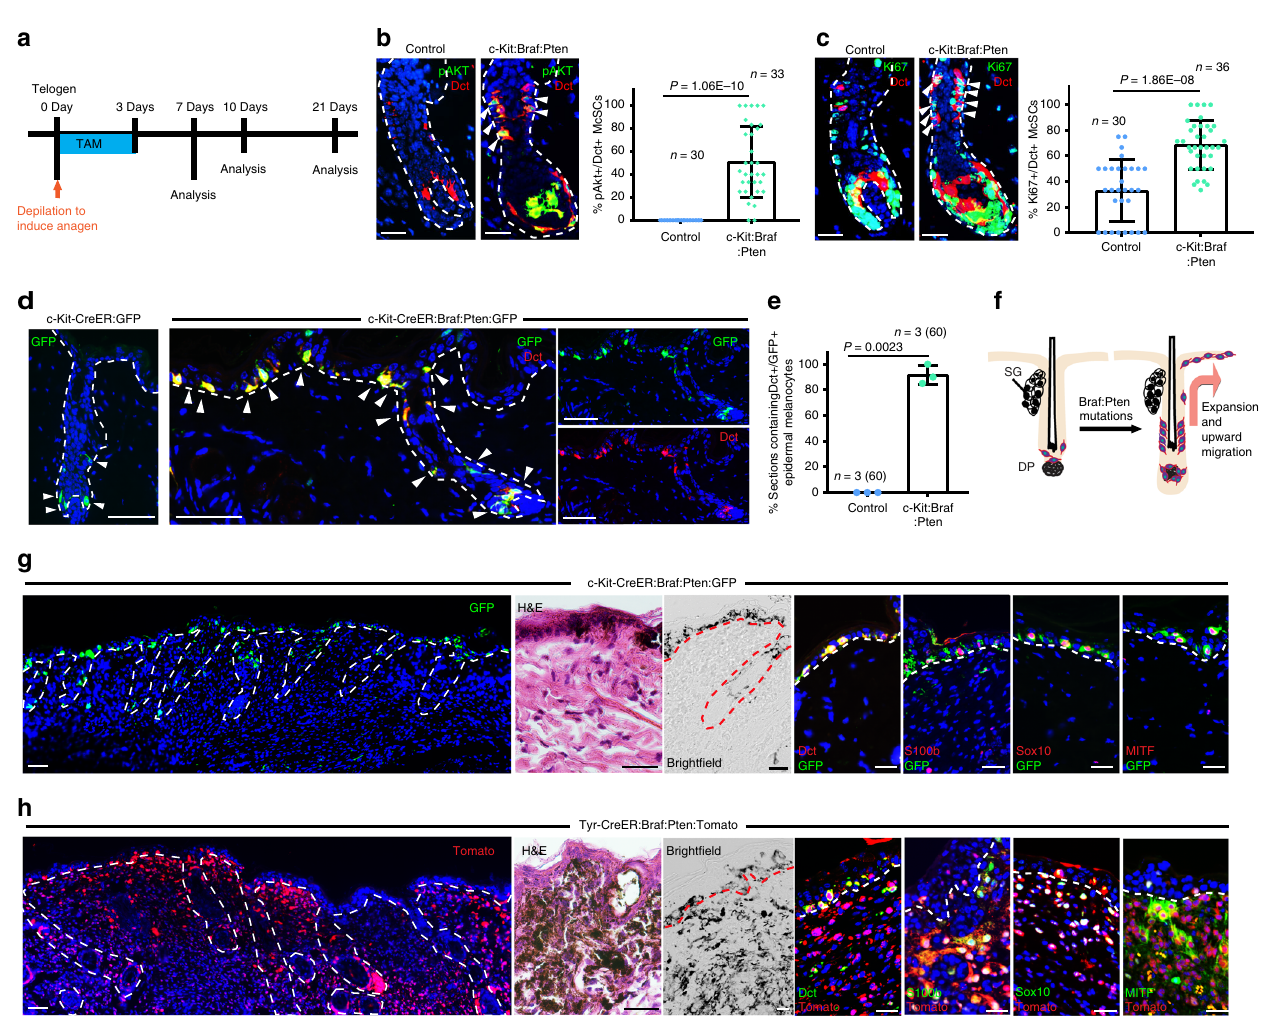
Fig. 2 C-Kit-CreER targeted McSCs form epidermal melanoma following induction of Braf:Pten mutations. a Schematic shows TAM treatment and analysis regimen of b – h . b Immuno fl uorescence images show Dct (red) and pAKT (green) in control (left) and c-Kit-CreER:Braf:Pten (middle) skin at 7 days after initial TAM. Dot plot shows percentage of pAKT + cells in Dct + McSCs (right) (mean± s.d.; n = 30 hair follicles from 3 control mice in control and 33 hair follicles from 3 c-Kit-CreER:Braf:Pten mice). c Immuno fl uorescence images show Dct (red) and Ki67 (green) in control (left) and c-Kit-CreER:Braf:Pten (middle) skin at 7 days after initial TAM. Dot plot shows percentage of Ki67 + cells in Dct + McSCs (right) (mean ± s.d.; n = 30 hair follicles from 3 control mice in control and 36 hair follicles from 3 c-Kit-CreER:Braf:Pten mice). d Immuno fl uorescence images showing GFP (green) in c-Kit-CreER; R26R-GFP control mice (left panel) and GFP (green) and Dct (red) in c-Kit-CreER:Braf:Pten:GFP mice (right panels) at 10 days after initial TAM (Left). The rightmost panels show the separate channel images to demonstrate the co-localization of GFP and Dct signals. e Dot plot shows percentage of 6um tissue sections ( > 500 µ m length) that contain Dct + /GFP + epidermal melanocytes in control and c-Kit-CreER:Braf:Pten:GFP mice (mean ± s.d.; n = 3 mice, total number of tissue sections analyzed is indicated in parenthesis in each group). f Schematic model showing that upon oncogenic mutations, McSCs expand in the niche and migrate upward to the epidermis. g Immuno fl uorescence images showing GFP (green) and Dct, S100b, Sox10, MITF (red), H&E or bright fi eld images in c-Kit-CreER:Braf:Pten:GFP mice at 21 days after initial TAM. h Immuno fl uorescence images showing Tomato (red) and Dct, S100b, Sox10, MITF (green), H&E or bright fi eld images in Tyr-CreER:Braf:Pten:Tomato mice at 21 days after initial TAM. Dashed line outlines the boundary of epithelium and dermis. Scale bars, 25 μ m, except for d and the leftmost panel of g and h , which are 50 μ m. Arrowheads point to follicular McSCs, except in d , where they also de fi ne epidermal melanocytes. HF hair follicle, McSCs melanocyte stem cells, SG sebaceous gland, DP dermal papilla. Source data are provided as a Source Data fi